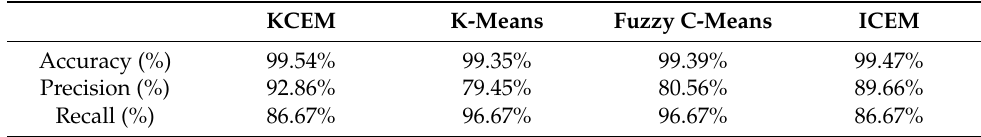
Table 6. Mass tumor: Confusion matrix.